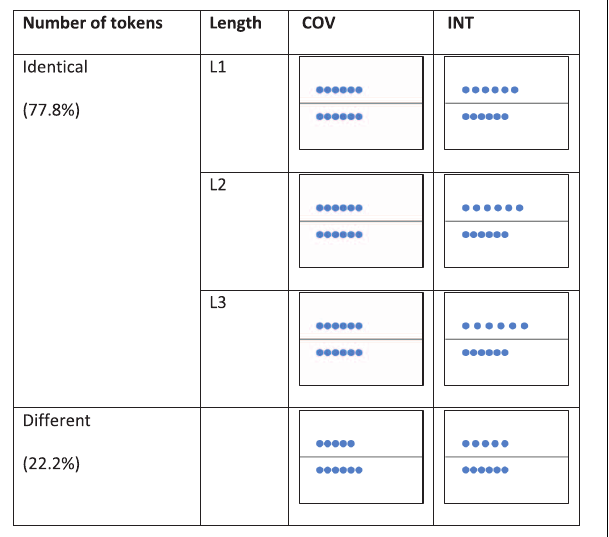
FIGURE 1 | Examples of stimuli presented in the COV and the INT conditions of the number-conservation